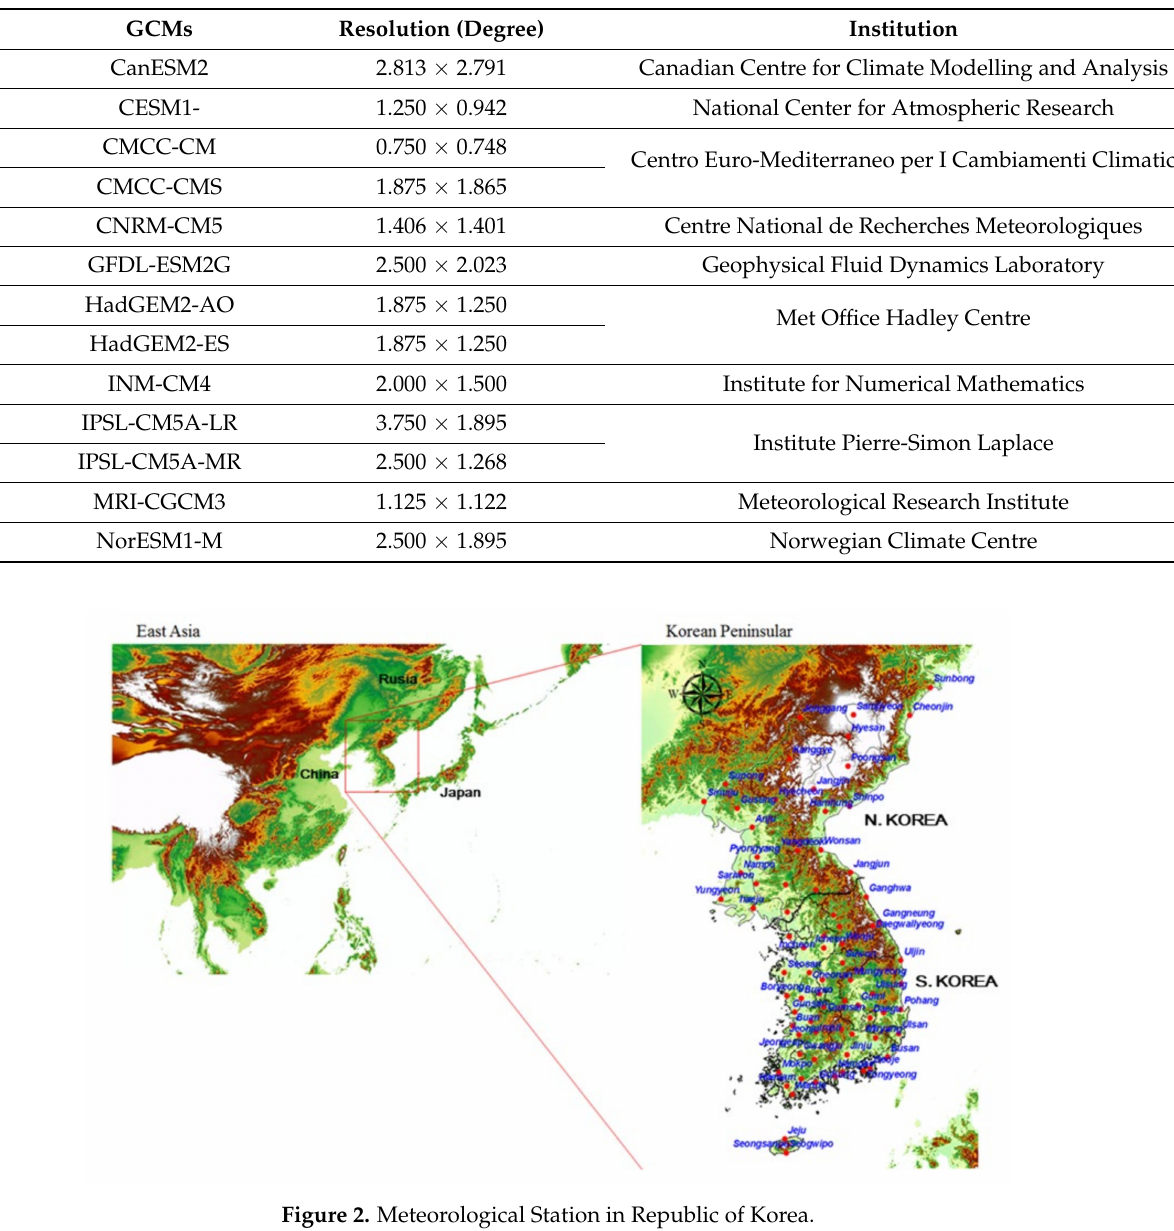
Table 1. Global Climate Models.